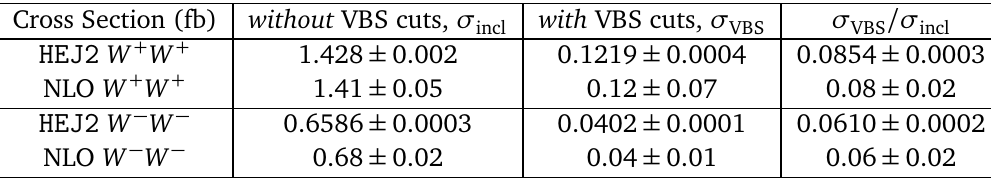
Table 1: Cross section obtained at LO + LL accuracy using HEJ2 compared with the result at NLO accuracy, both before and after the additional VBS cuts given in the